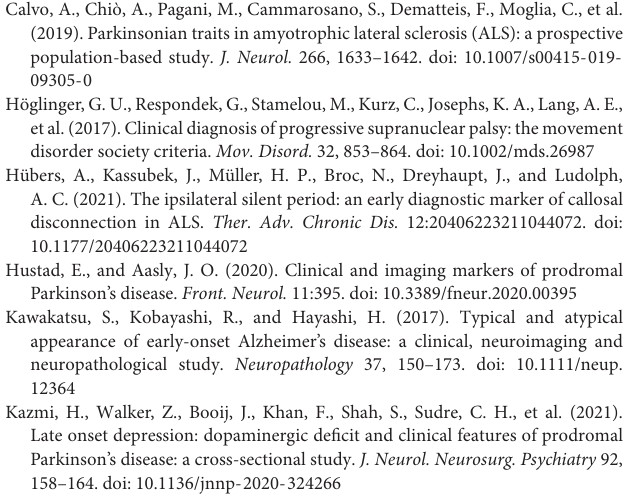
Supplementary Figure 1 | Histological observations of the substantia nigra, caudate and putamen in three autopsied cases. Neuronal loss is observed in the medial portion of the substantia nigra (A–C) , where astrogliosis is depicted (D–F) . Neuronal loss and astrogliosis are also evident in the caudate (G–I) and putamen (J–L) . Klüver-Barrera staining (A–C) and hematoxylin-eosin staining (D–L) . Scale bars: 200 µ m (A–C) and 100 µ m (D–L)